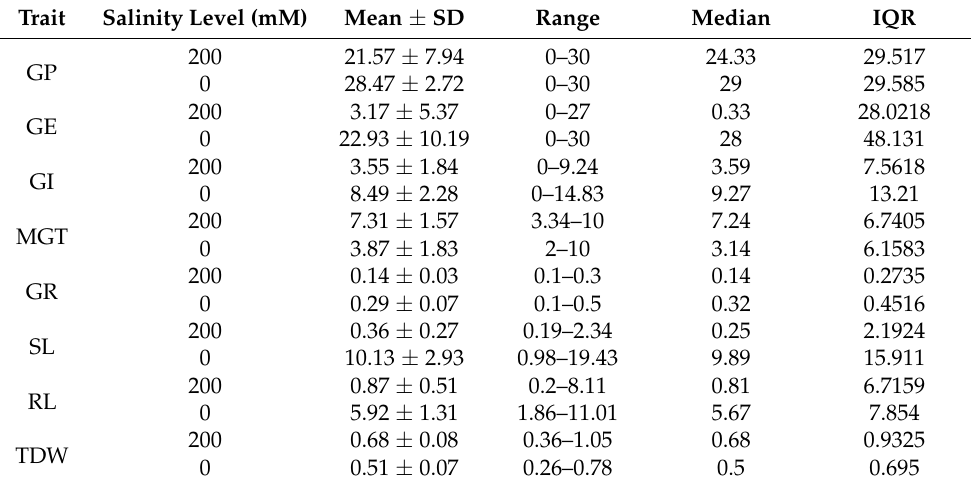
Table 2. Descriptive statistics for the mean value of the traits in the control and salt-treated (200 mM) rice accessions. GP: Germination Percentage; GE: Germination Energy; GI: Germination Index; GMT: Mean Germination Time; GR: Germination Rate; SL: Shoot Length; RL: Root Length; TDW: Total